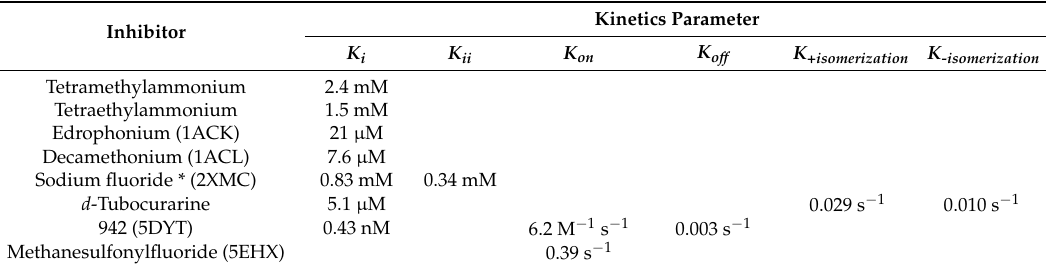
* from Figure 3. a :For standard errors, the application can be run at: http://enzo.cmm.ki.si/kinetic.php?uwd=170623269&load=true.